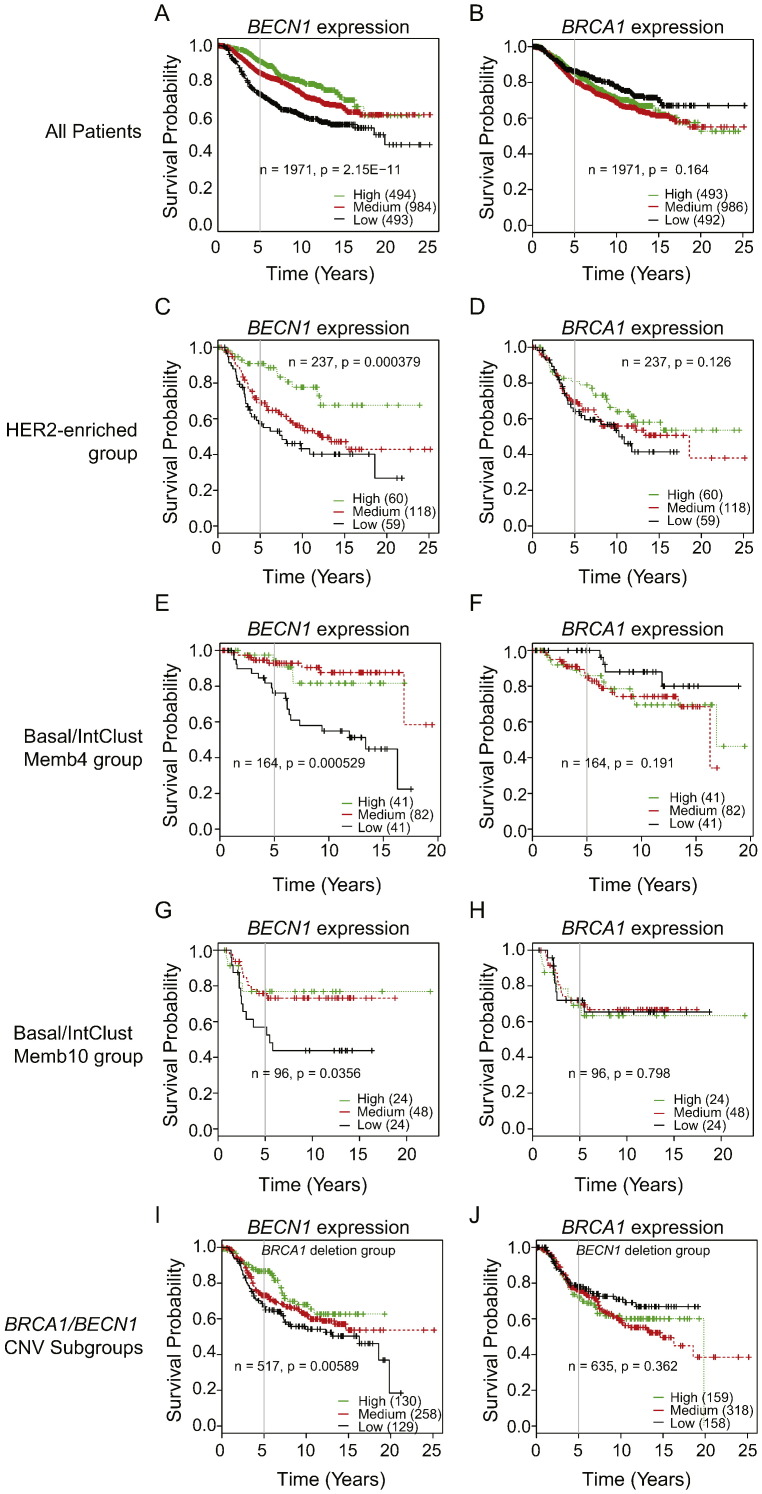
BECN1 expression but not BRCA1 expression is associated with disease-specific survival. Panels A and B: Kaplan–Meier curves for all patients for BECN1 expression (panel A) or BRCA1 (panel B) expression. Panels C through J: Kaplan–Meier curves within HER2-enriched group (panels C and D), Basal/IntClust Memb4 (panels E and F), Basal/IntClust Memb10 (panels G and H), and in copy number loss subgroups (panels I and J). Green, red and black lines indicate high (1st quartile), medium (2nd and 3rd quartiles), and low (4th quartile) expression level groups, respectively. + denotes censored observations. P values were obtained by the Cox regression model assuming an ordered trend for the three expression groups.